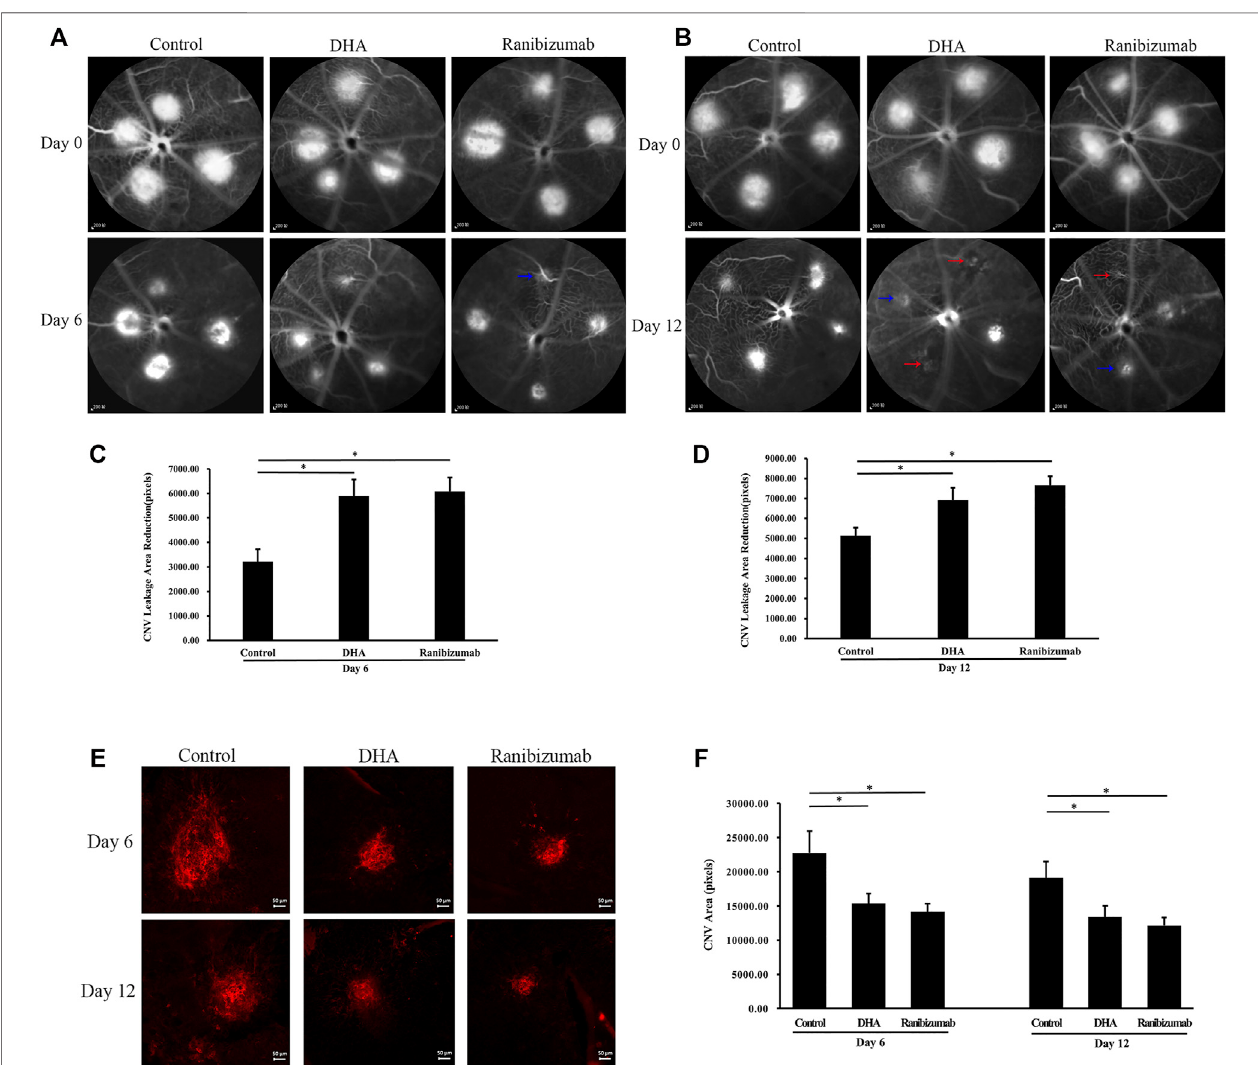
FIGURE2| TheeffectofDHAontheCNVlesionareawasshownbyFFAandchoroidal fl at-mountstaining.TheCNVlesionsweregradedaccordingtotheintensity oftheleaking fl uorescence.Grade1wasindicatedbyredarrows.Grade2wasindicatedbybluearrows. (A,B) Representativelate-phase fl uoresceinangiogramsonday 6 and day 12. Scale bar, 200 μ m. (C,D) The reduction in the same CNV leakage area of the DHA group or ranibizumab group was signi fi cantly larger than that of the vehiclegrouponday6andday12. (E) Representativechoroidal fl at-mountimagesoflaser-inducedvascularlesions(stainedwithisolectinB4)onday6andday12. Scale bar, 50 μ m. (F) The CNV area decreased signi fi cantly after DHA or ranibizumab treatment compared to that in the vehicle group. Data were analyzed by one-way ANOVA followed by Tukey ’ s multiple comparisons test. * p < .05. CNV: Choroidal Neovascularization; DHA, Dihydroartemisinin; FFA, Fundus Fluorescein Angiography.